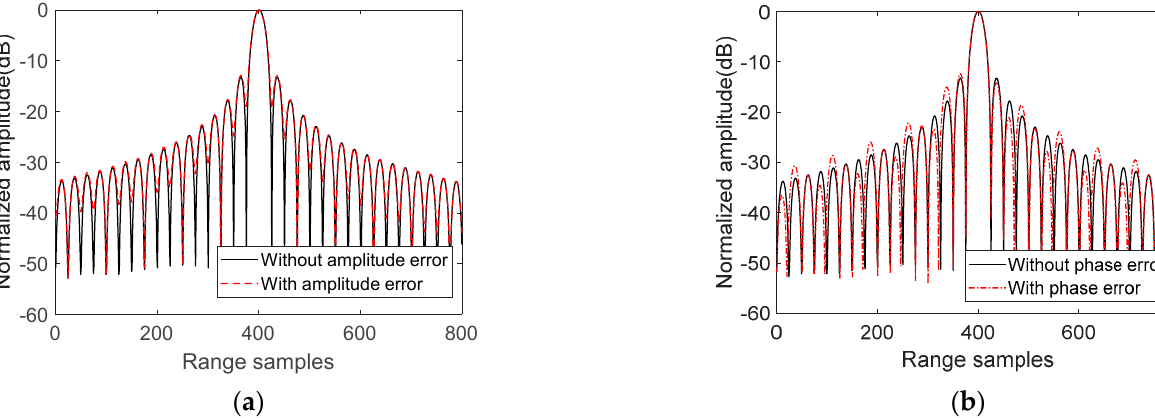
Figure 9. Pulse compression results of the improved DBF processor with multi-frequency time delays ( a ) Pulse compression results with amplitude errors between different frequency sub-bands. ( b ) Pulse compression results with phase errors between different frequency sub-bands.